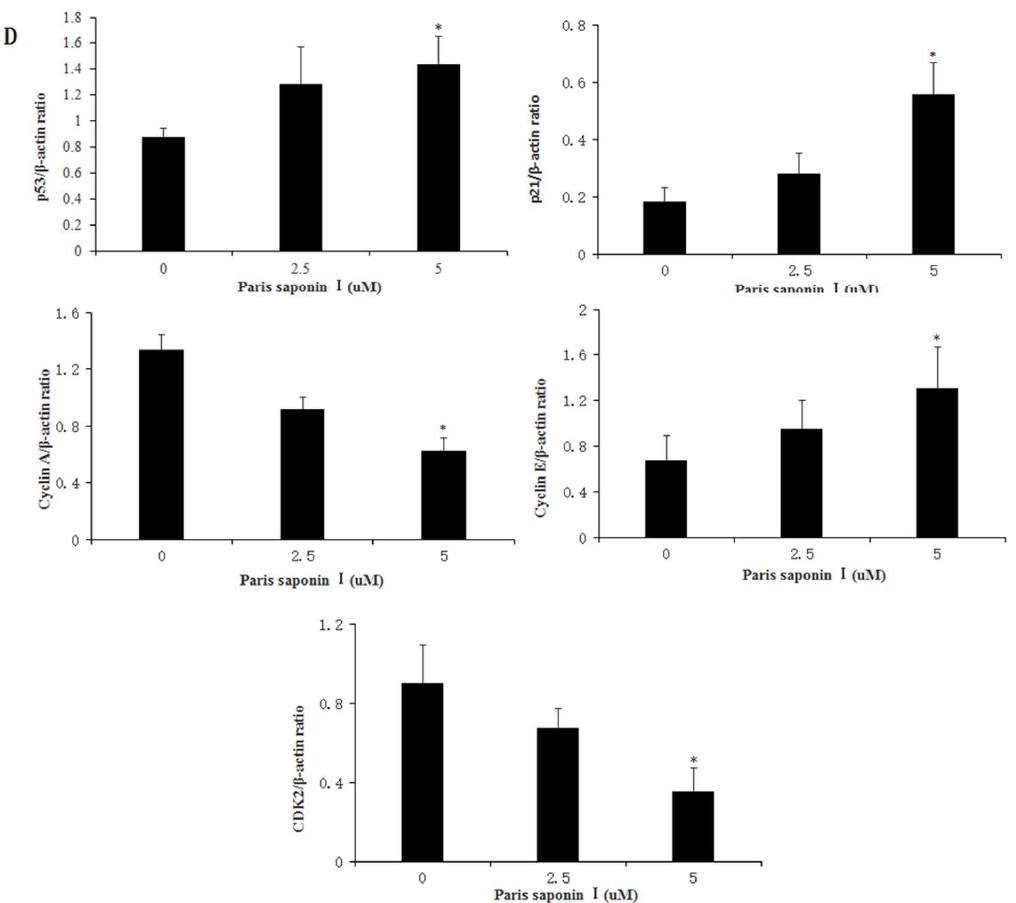
Figure 8. The e ff ect of PSI on cell cycle. ( A ) HepaRG cell cycle distribution graphs for di ff erent groups, as measured with flow cytometry. ( B ) A broken line graph indicating the percentage of HepaRG cells in each phase of the cell cycle. ( C ) Protein expression levels of p53, p21, cyclinA, cyclin E, and CDK2, as determined using Western blotting. ( D ) Quantitative display of optical density values. Data are expressed as mean ± SD. * p < 0.05, compared with the vehicle-treated